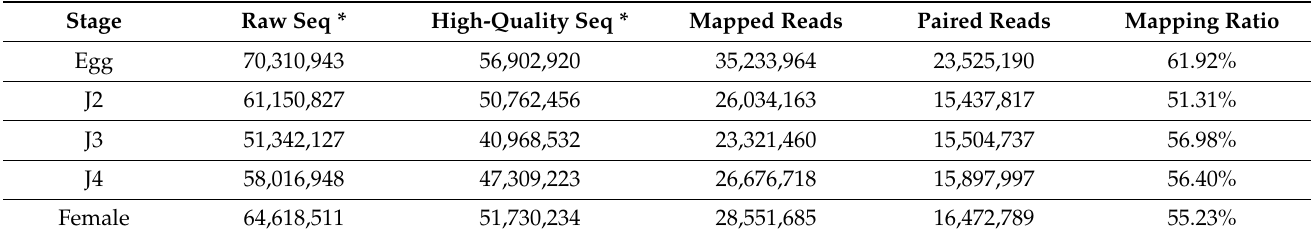
Table 1. Stage-wise statistics of M. incognita mRNA.